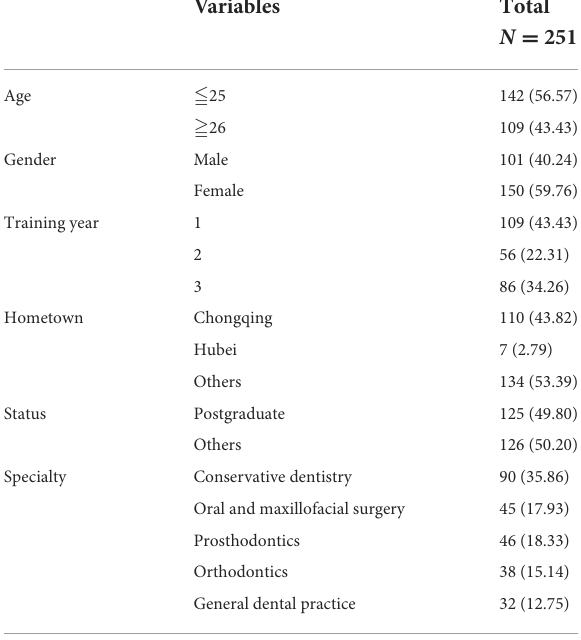
TABLE 1 Characteristics of